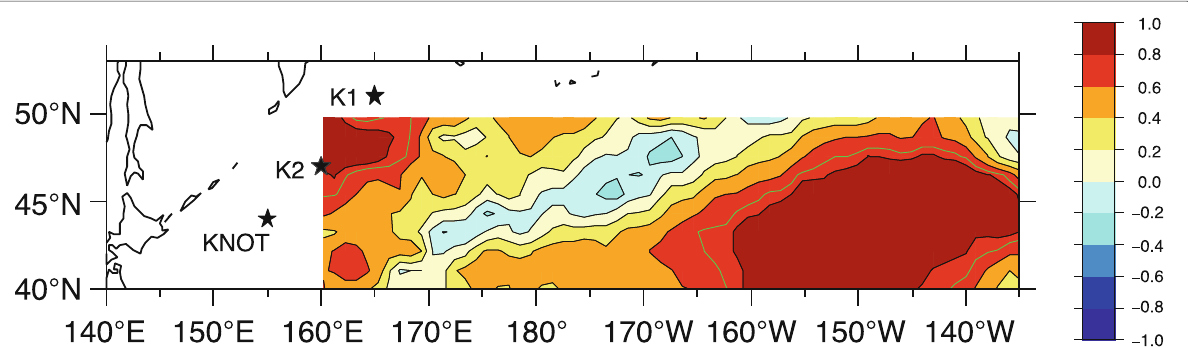
Fig. 6 Map of correlation coefficient between altimetric and simulated SSH variations in the region of 40–50° N, 160° E–135° W. Contour interval is 0.2. The 90% confidence interval (0.73) is illustrated by green contours. Variations in SSH smoothed by a 35-month running mean filter were used to calculate correlation coefficients. Locations of stations K1, K2, and KNOT are indicated by